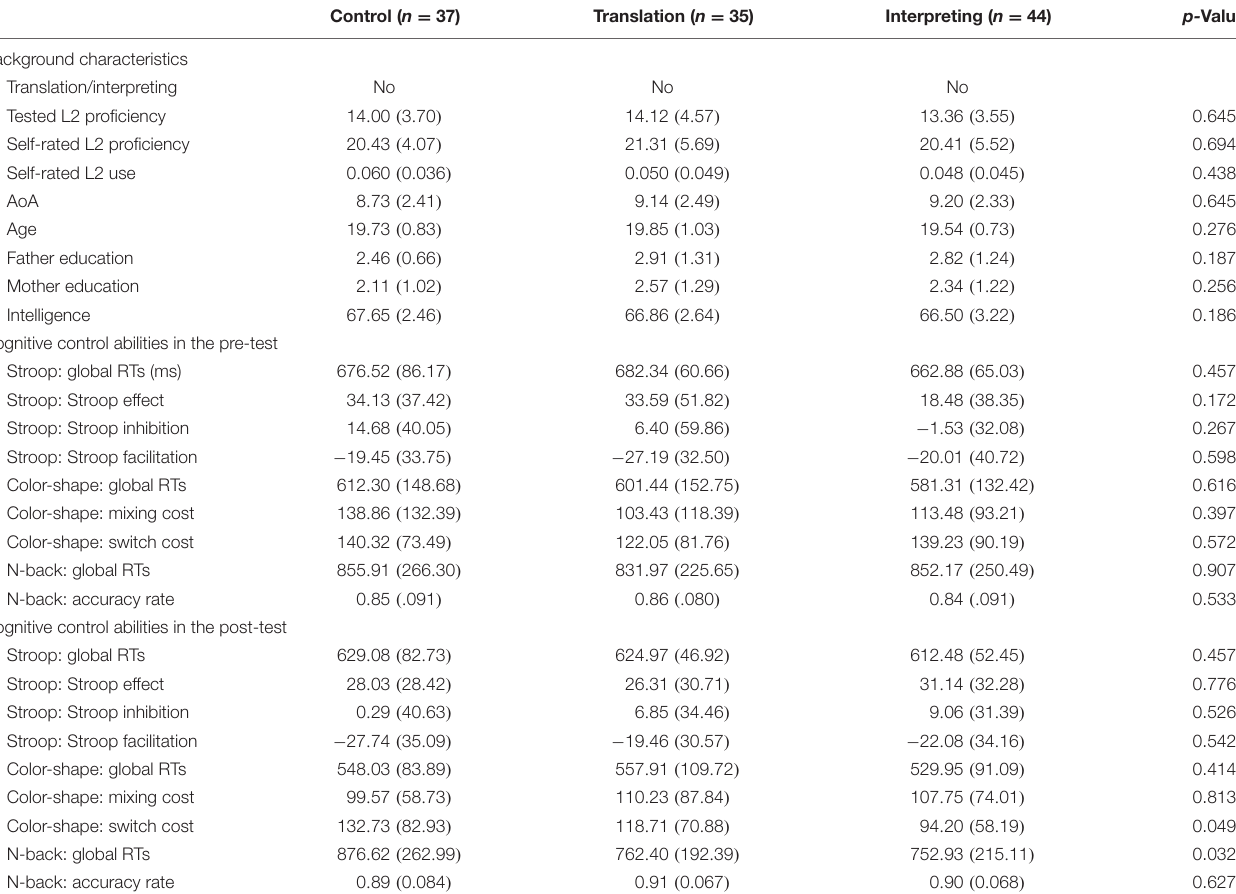
TABLE 5 | Group means (with SD) and comparisons (p value) of participants’ background characteristics and task performances in pre- and post- tests after group match. Control ( n = 37) Translation ( n = 35) Interpreting ( n = 44) p- Value